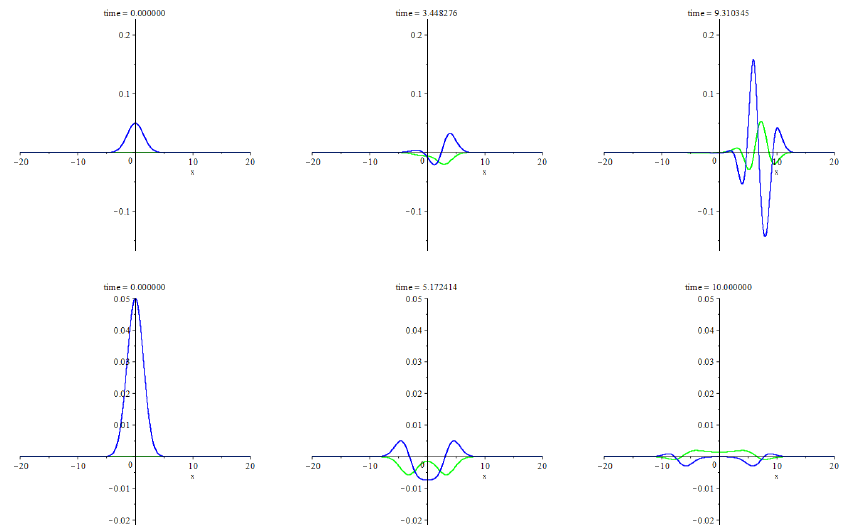
Figure 3. The typical pattern of the smooth localized perturbation with or without the wind, see Section 7 for specific settings. Each frame shows instantaneous graphs of the deviation of the species densities from their equilibrium values. At that, blue (green) colour corresponds to the preda- tor (prey) and the horizontal axis corresponds to the spatial coordinate, x . The upper row displays growth and sharpening of the perturbation due to the wind-induced pumping. Parameter θ < 0 is maximal in the absolute value. The snapshot timing, left to right, is t ≈ 0.0,3.4,9.3. The bottom row displays a decaying pattern with no wind so that θ = 0. The snapshot timing, left to right, is t ≈